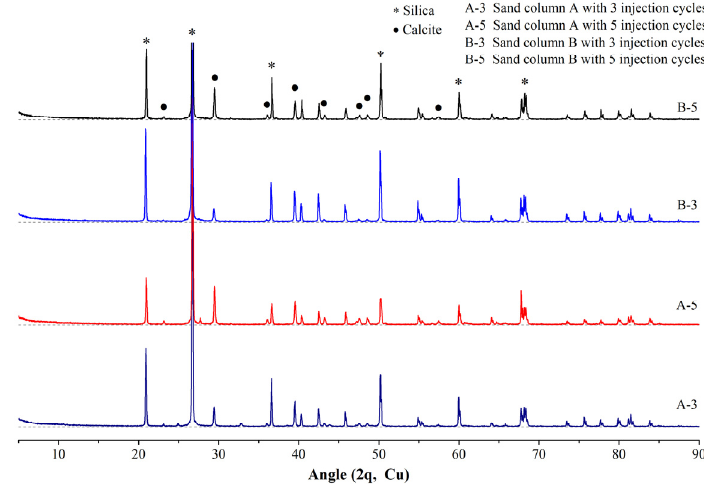
Figure 7. XRD results of cemented sand columns.